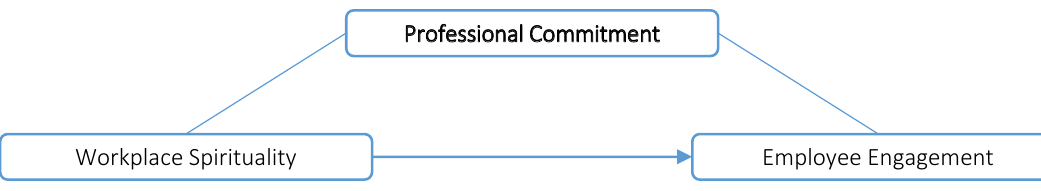
Figure 1. The relationship between workplace spirituality, employee